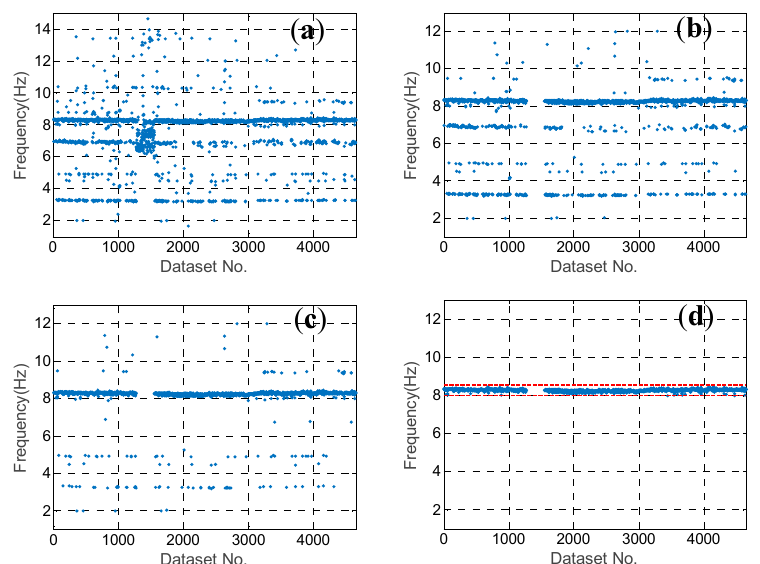
Figure 8. The results of the candidate mode of modal frequency 8.26 Hz at each step: ( a ) after the 1st step with the largest similarity coefficient in every dataset selected; ( b ) after the 2nd step with the ones with MAC ≥ 0.8 left; ( c ) after the 3rd step with the MAC fulfilling the Tukey’s fence criterion; and ( d ) after the 4th step with the modal frequency fulfilling the Tukey’s fence criterion.